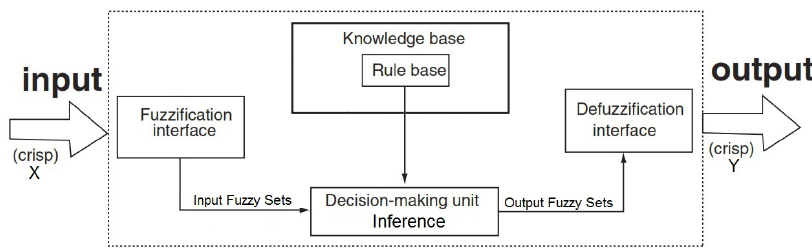
Figure 1. Fuzzy inference